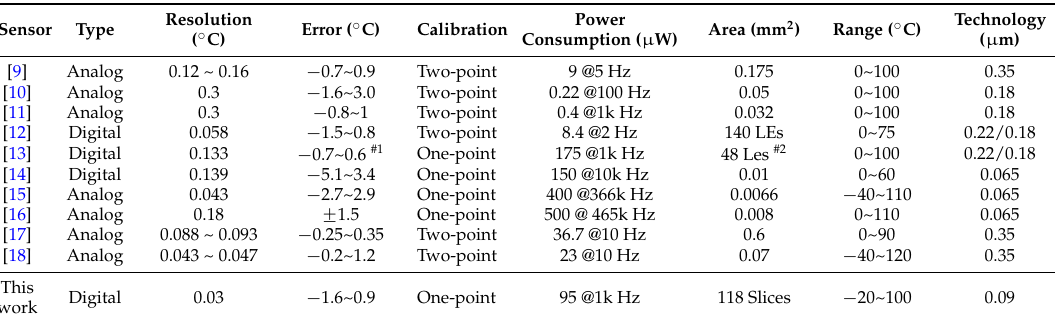
Table 2. Performance comparisons among related